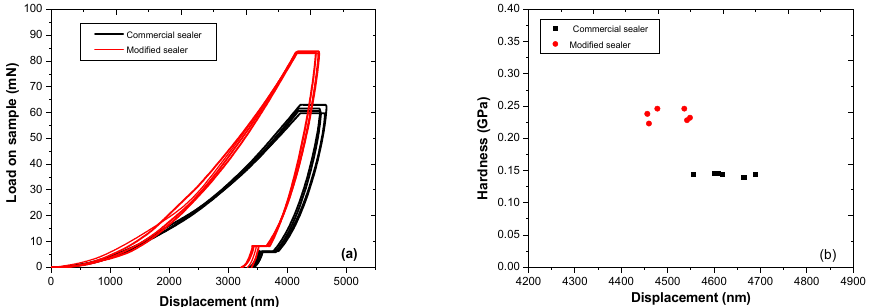
Figure 6. Load–displacement curves ( a ) recorded on the surface of commercial (black) and modified sealer (red) and the corresponding Young modulus calculation ( b ).